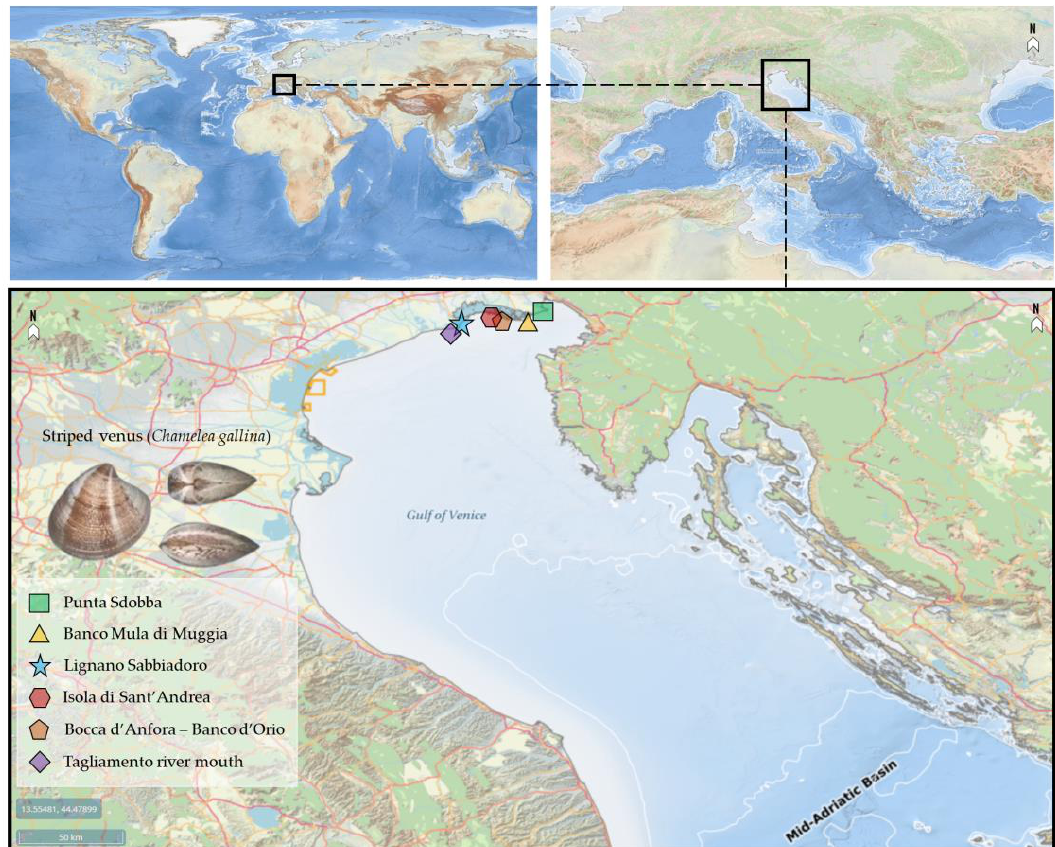
Figure 3. Coastal strip area of Friuli-Venezia Giulia (northeast Italy) investigated for the presence of Chamelea gallina . Each symbol represents a sampling site (modified from https://www.emodnet-bathymetry.eu/, accessed on 23 August 2022).